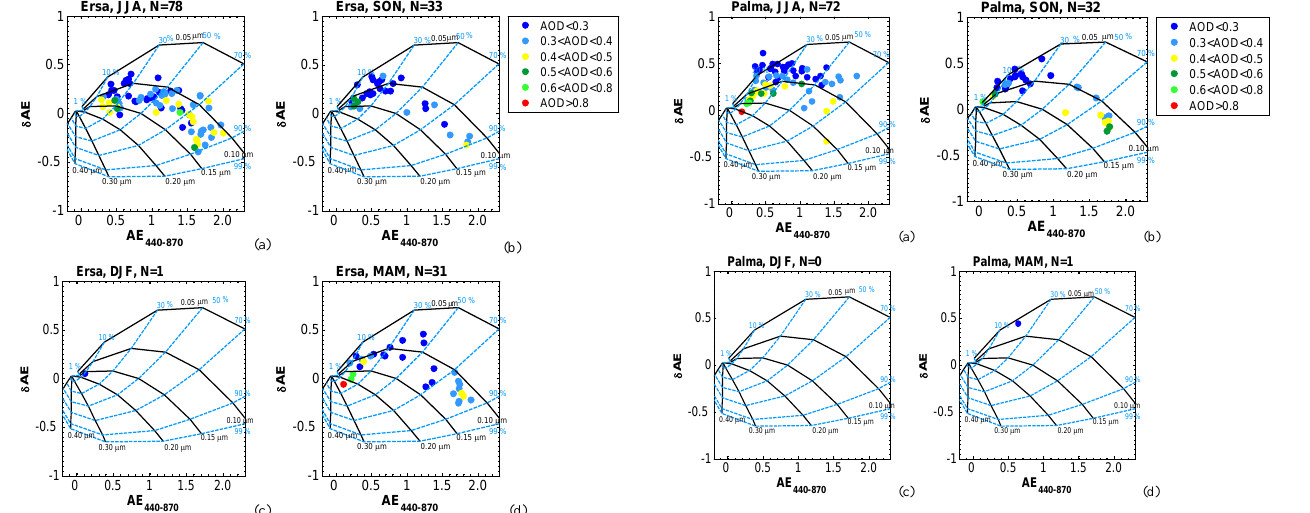
Figure 4. Ångström exponent difference ( δ AE = AE 440 − 675 – AE 675 − 870 ) as a function of the Ångström exponent calculated be- tween 440 and 870nm (AE 440 − 870 ) at Ersa during (a) summer, (b) autumn, (c) winter and (d) spring, for the whole 2011–2015 AERONET level 2.0 daily aerosol optical depth (AOD) dataset. Only points with AOD 675 >0.15 are represented. However, the AOD plotted is AOD 440 (and not AOD 675 ) in order to be di- rectly comparable with the AERONET inversion criteria based on AOD 440 . The legend applies for all plots. A bimodal, lognormal size distribution and a refractive index of 1.4–0.001 i are considered to construct the grid. The black solid lines are each for a fixed fine- mode radius and the dashed blue lines for a fixed fraction of the fine-mode contribution to the AOD at 675nm.